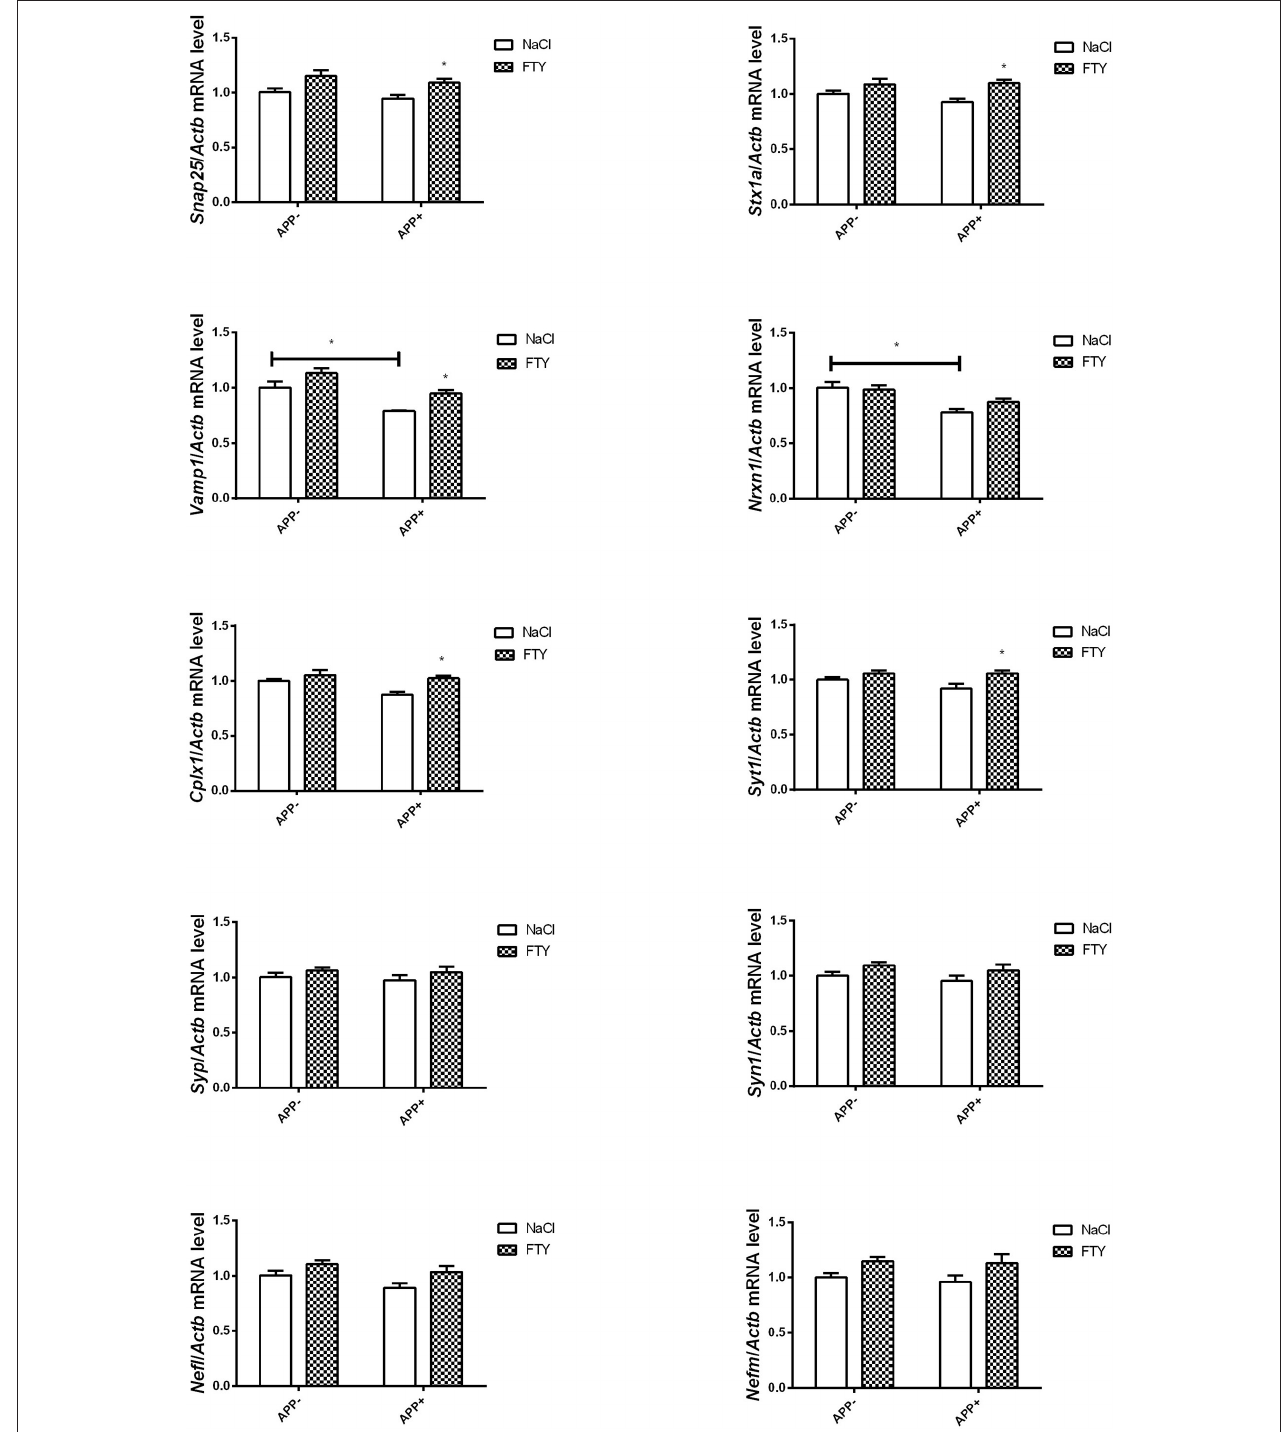
FIGURE 3 | Levels of mRNAs coding for synaptic proteins in 12-month-old cortex: effect of A β PP and FTY720. Levels of mRNAs measured with real-time PCR in the cerebral cortex of 12-month-old (old adult) mice as described in Materials and methods. mRNA levels in A β PP-expressing mice were compared with control animals that did not inherit the transgene. Effect of FTY720 administration was assessed against vehicle-treated animals in each group. Snap25 , synaptosomal-associated protein, 25kDa; Stx1a , syntaxin 1A; Vamp1 , vesicle-associated membrane protein 1; Nrxn1 , neurexin 1; Cplx1 , complexin 1; Syt1 , synaptotagmin 1; Syp , synaptophysin; Syn1 , synapsin 1; Nefl , neurofilament light; Nefm , neurofilament medium; APP − , animals without V717I A β PP transgene; APP + , mice expressing V717I A β PP transgene. * p < 0.05 vs. corresponding controls, two-way ANOVA followed by Tukey’s post-hoc test (horizontal bars: effect of A β PP; significances marked over FTY720 values: effect of FTY720 treatment within each animal group). n = 3–6, measured in triplicate ( n = 6–9 for Cplx1 , Snap25 , Syn1 , and Nefl ) ± SEM.